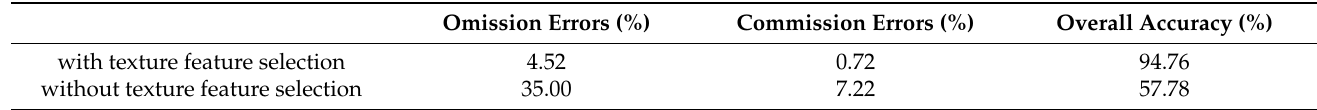
Table 10. Accuracy of outlier detection with and without texture feature